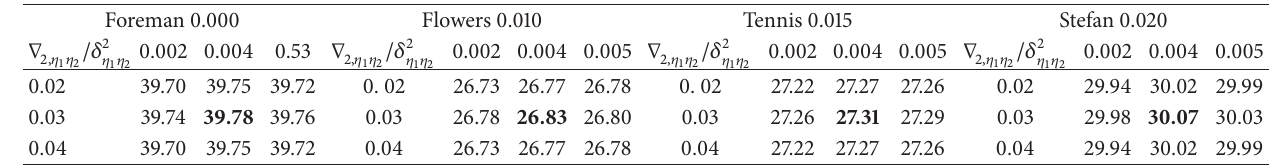
and 𝛿 2 𝜂 parameters in membership functions . 1 𝜂 2 1 𝜂 2